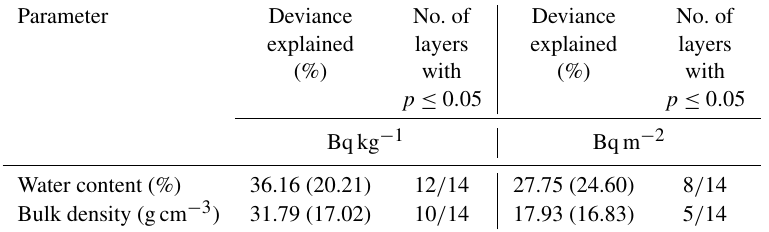
Table 5. The results of single soil property parameter GAMs for deviance explained and the number of depth layers where p values were equal to or less than 0.05. “()” indicates standard deviation. Parameter Deviance No. of Deviance No. of explained layers explained layers (%) with (%) with p ≤ 0 .